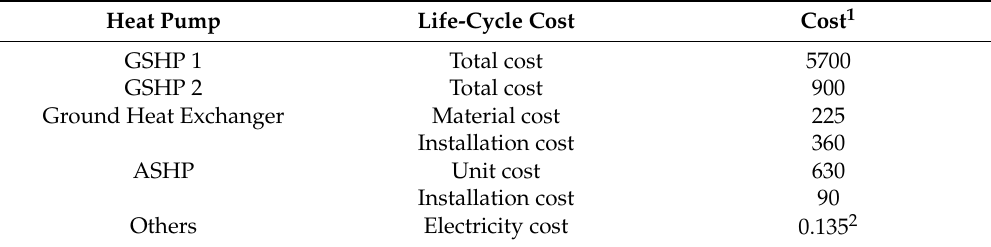
Table 3. Initial and installation costs of each heat pump and heat exchanger.